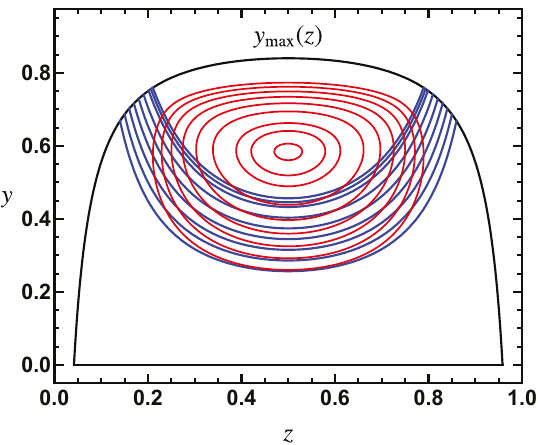
Figure 20 . Phase space diagram in ( z; y ) coordinates (black lines) showing curves with constant value of the C-parameter event-shape measurement function (in red) and for its soft limit (in blue), for the same set of C values f 0 : 42 ; 0 : 468 ; 0 : 516 ; 0 : 564 ; 0 : 612 ; 0 : 66 ; 0 : 708 ; 0 : 729 ; 0 : 747 g , while ^ m = 0 : 2. Red curves are always contained withing the phase-space boundaries, and the enclosed area becomes smaller as the value of C approaches its maximum value, when it collapses to a single point. Blue curves always intersect with the phase-space boundary, and have a (cid:12)nite extension even for C = C max . Blue and red curves are similar for small values of y